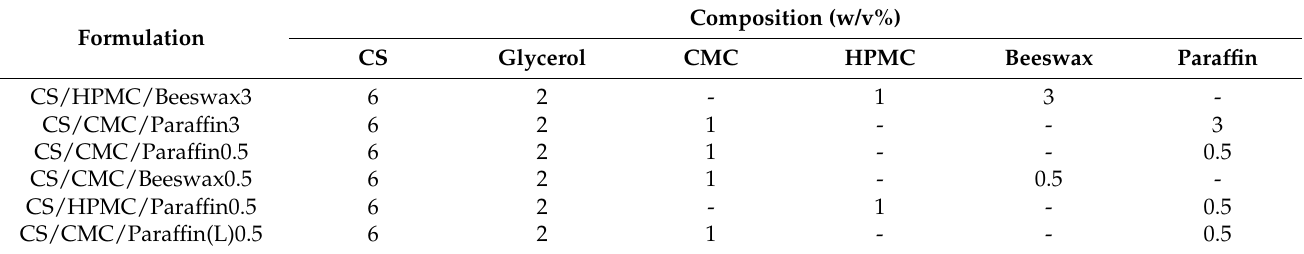
Table 1. Composition of the coating materials made from cassava starch (CS), glycerol, carboxymethyl cellulose (CMC), hydroxypropyl methylcellulose (HPMC), beeswax, and paraffin wax. Composition (w/v%) Formulation CS Glycerol CMC HPMC Beeswax Paraffin CS/HPMC/Beeswax3 6 CS/CMC/Paraffin3 CS/CMC/Paraffin0.5 CS/CMC/Beeswax0.5 CS/HPMC/Paraffin0.5